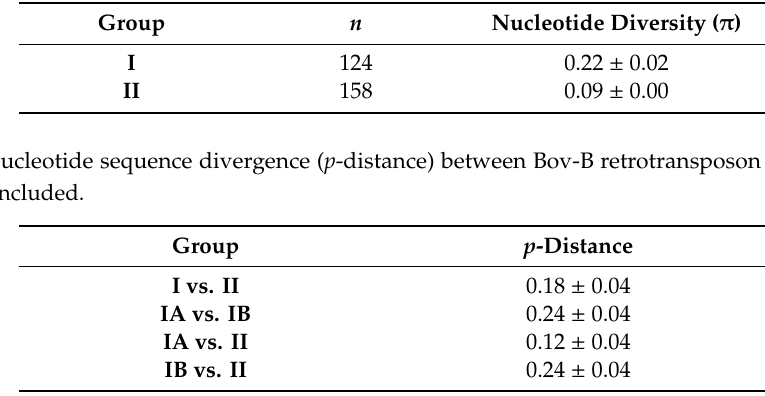
Table 6. Nucleotide diversity ( π ) of Bov-B LINE retrotransposon groups with outgroups included.